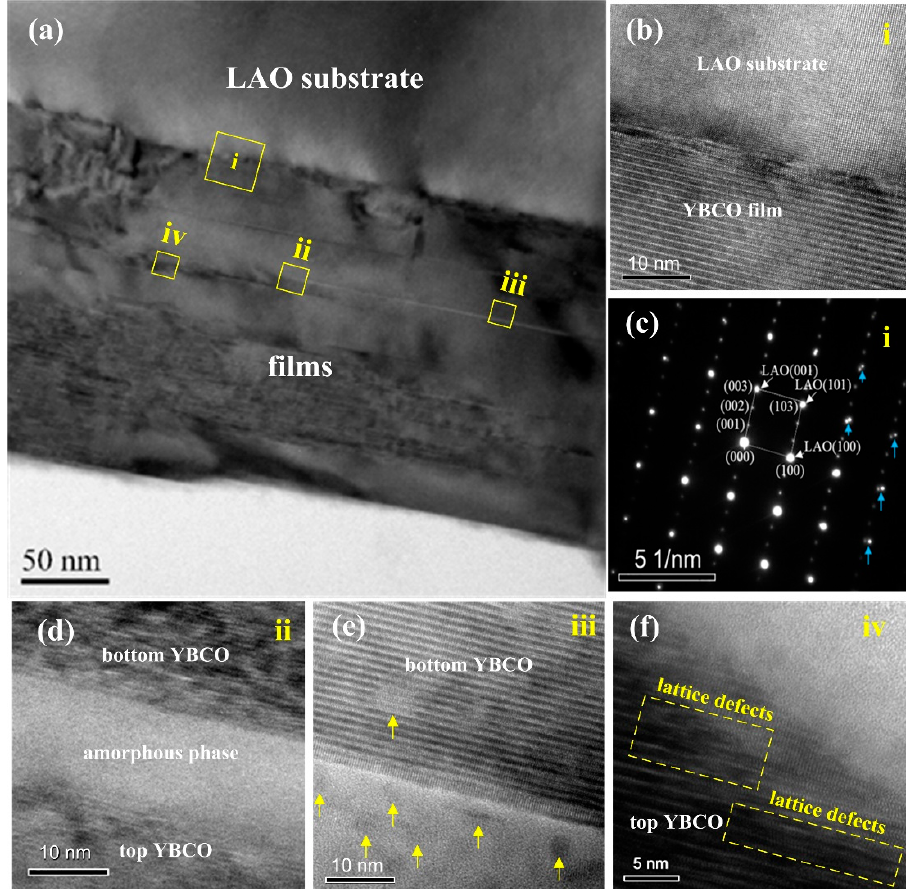
Figure 6. Cross-section TEM images of YBCO/LAO/YBCO quasi-trilayer (sample SIS-20): ( a ) shows the overall structure of the quasi-trilayer; ( b , c ) are the high resolution transmission electron microscope (HRTEM) and selected area electron diffraction (SAED) of the interface between the bottom YBCO layer and the LAO substrate, respectively; and ( d – f ) is the HRTEM of the interface between YBCO and LAO films.